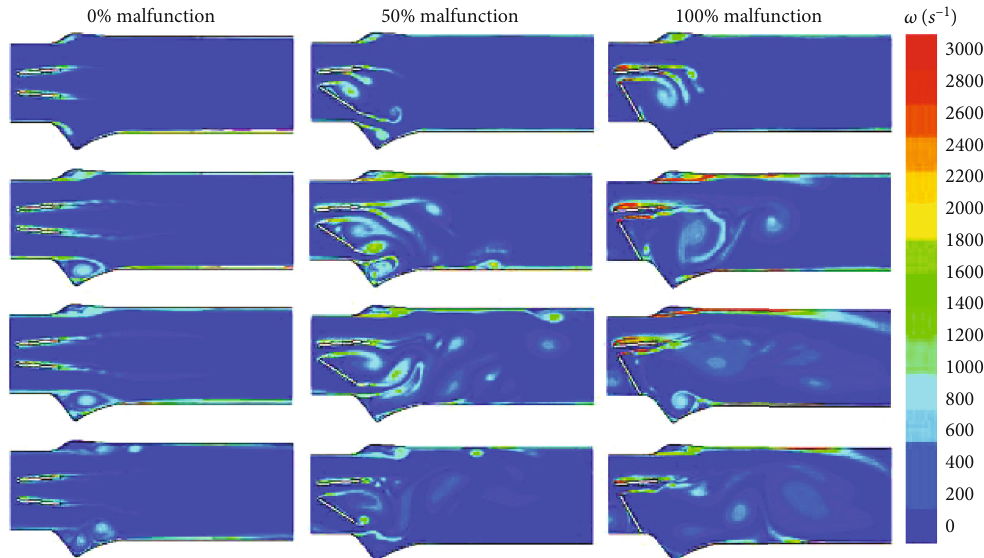
Figure 4: Vorticity distributions and coherent structure downstream of a healthy and a dysfunctional mechanical valve at di ff erent time instants